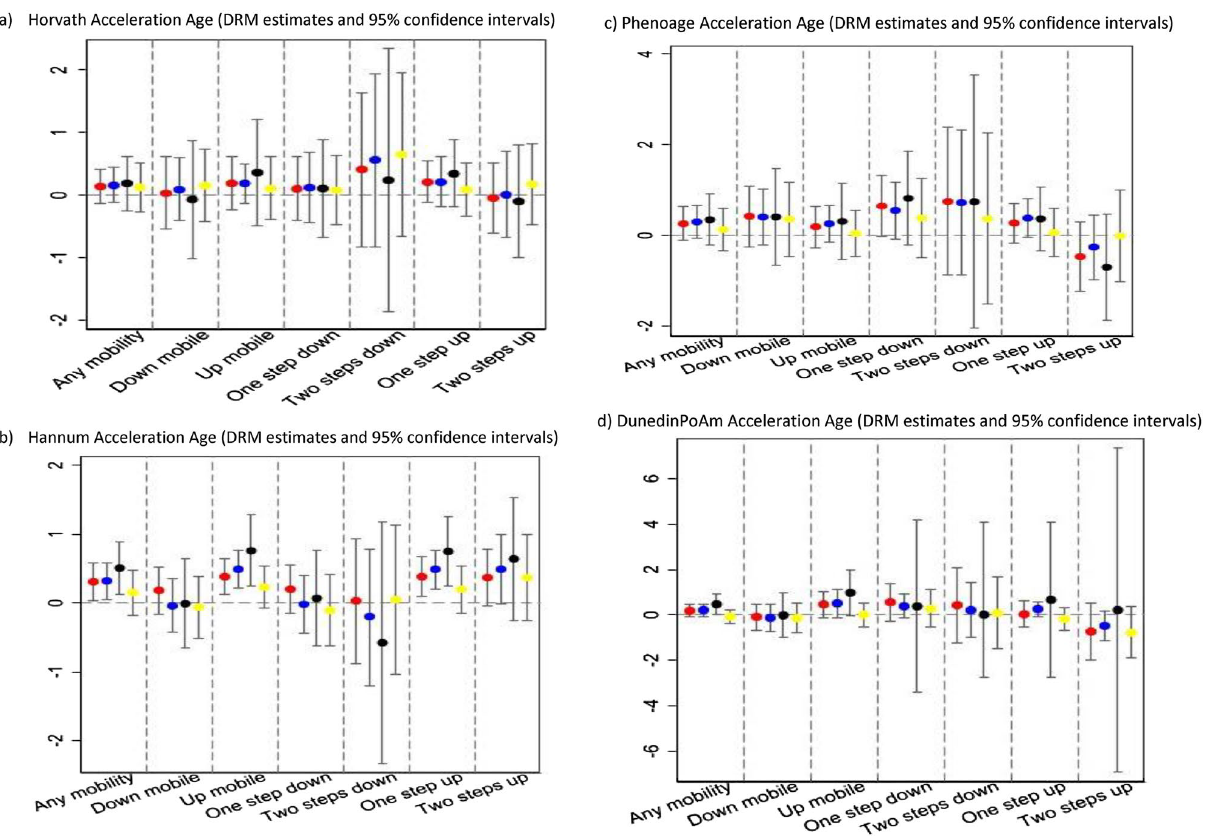
Figure 1. DRM estimate and 95% CI of mobility variables with ( a ) Horvath, ( b ) Hannum, ( c ) phenoage, and ( d ) DunedinPoAm Acceleration Age. Point estimates from the main model (red dot), adjusted for additional covariates, marital status and educational attainment (blue dot) and stratification of the sample to those born before 1956, the median year in the study (black dot) and those born after 1956 (yellow dot). Values above 0 represent positive accelerated age, i.e. older than chronological age and values below 0 represent negative accelerated age, i.e. younger than chronological